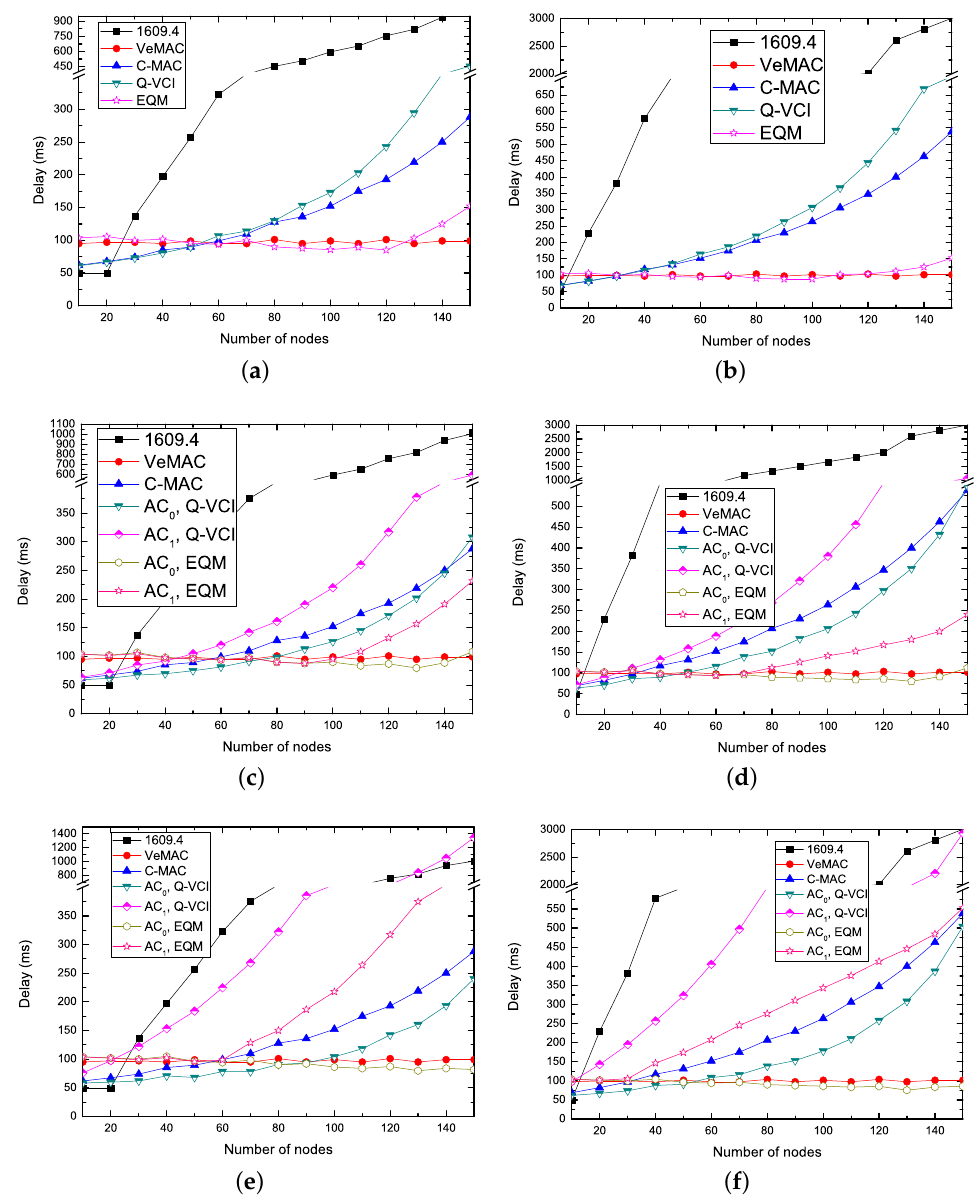
Figure 8. Non-safety packet delay versus the number of nodes for kinds of protocols ( N 0 = N 1